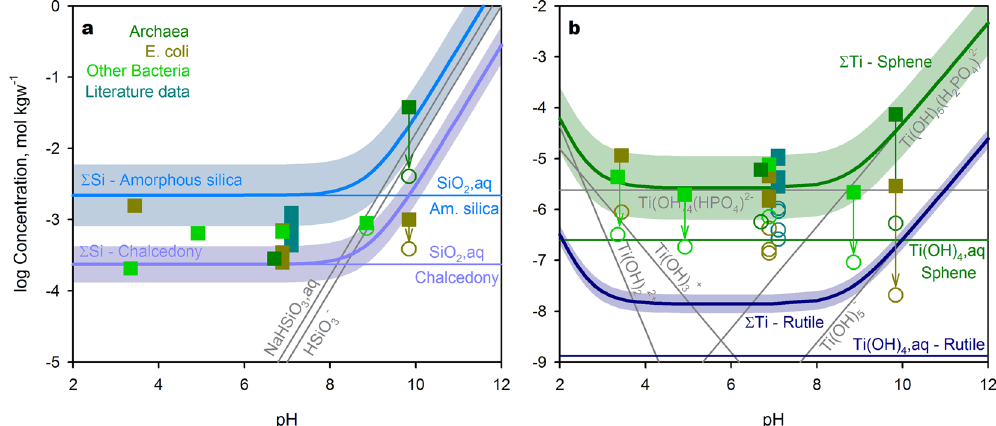
Figure 3. Si and Ti speciation in fluids saturated with respect to various minerals versus contents in prokaryotes. ( a ) The Σ Si and SiO 2 ,aq in solutions saturated with amorphous silica and chalcedony. NaHSiO 3 ,aq and HSiO 3 − trends correspond to saturation in amorphous silica. ( b ) The bulk Ti content and solution species correspond to saturation level of sphene and rutile at pH = 7 and cation composition of E. coli . They are propagated to other pH values assuming the same content of Ti(OH) 4 ,aq. In the case of rutile, Σ Ti and Ti(OH) 4 ,aq are shown only. Uncertainties (2 σ ) on thermodynamically predicted total Si and Ti are shown by shaded regions. The prokaryotic abundances are marked with squares scaled by their 2 σ uncertainty.